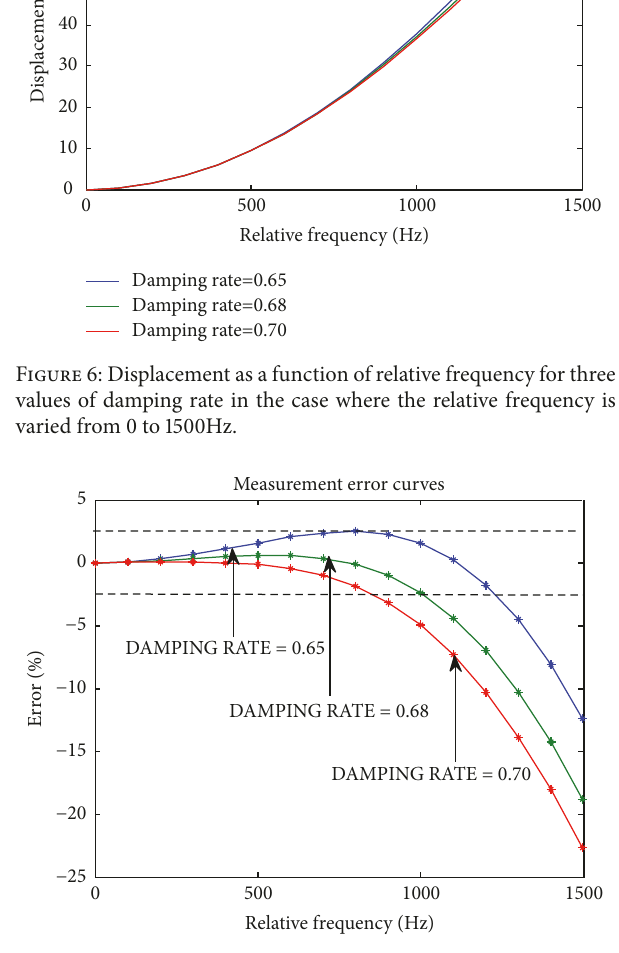
Figure 5: Measurement error as a function of relative frequency for three values of damping rate in the resonance case.